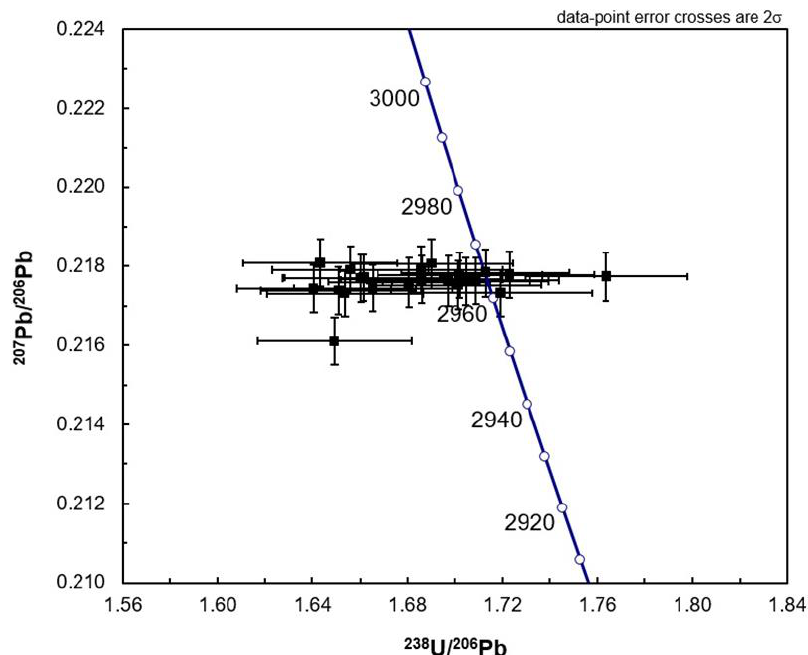
Figure 10. U–Pb isotope data from zircon measured in situ in porphyritic dunite sample 186460, yielding a weighted age of 2963 ± 1 Ma. This age represents a maximum age of the talc formation.